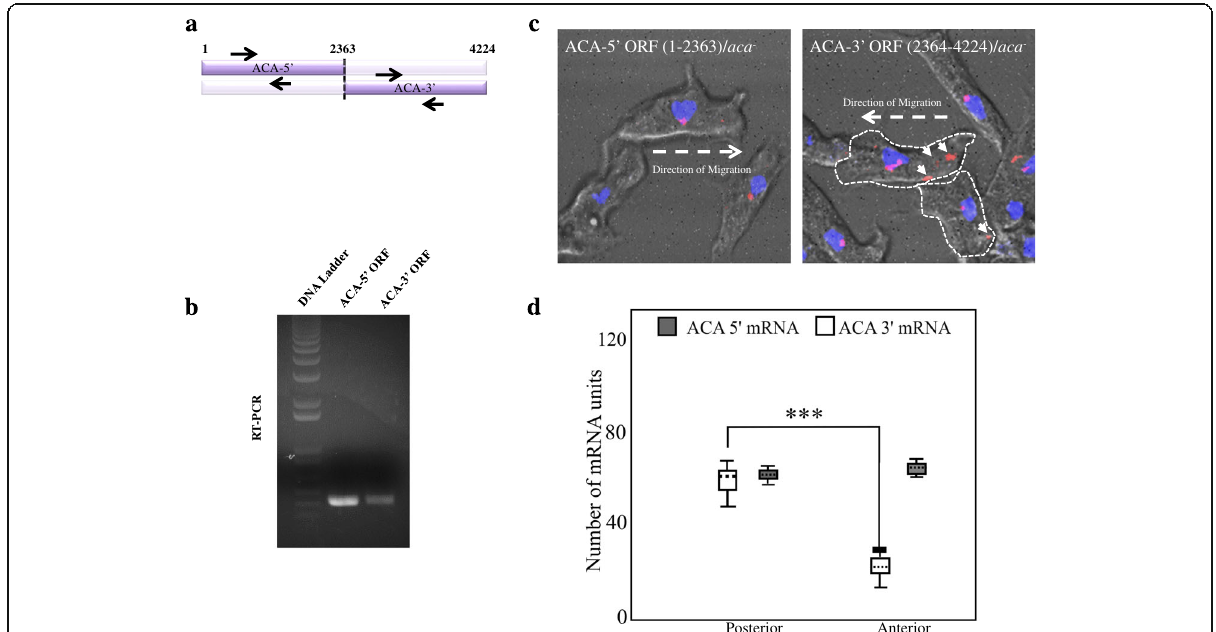
Fig. 4 ACA mRNA localization at the posterior of migrating cells requires 3 ′ ACA cis-acting elements. a Schematic of the ACA-5 ’ ORF or ACA-3 ’ ORF constructs and the location of specific ACA primers used in these experiments ( black arrows ). b RT-PCR of the ACA-5 ’ ORF or ACA-3 ’ ORF cell lines using specific ACA primers. c Representative merged phase contrast and maximum intensity confocal fluorescent images depicting DAPI ( blue ) and ACA mRNA ( pink ) in ACA-5 ′ ORF/ aca − and ACA-3 ′ ORF/ aca − cells. d The simulated estimate of ACA mRNA units across cells is plotted for ACA-5 ′ ORF/ aca − and ACA-3 ′ ORF/ aca − cells. The boxes show the 50% confidence region from the median ( black dashed line ). The bars cover a region with 99% confidence level from the median. The statistical significance was inferred by the t-test: *** represents p < 0.01 ( n = 10 –